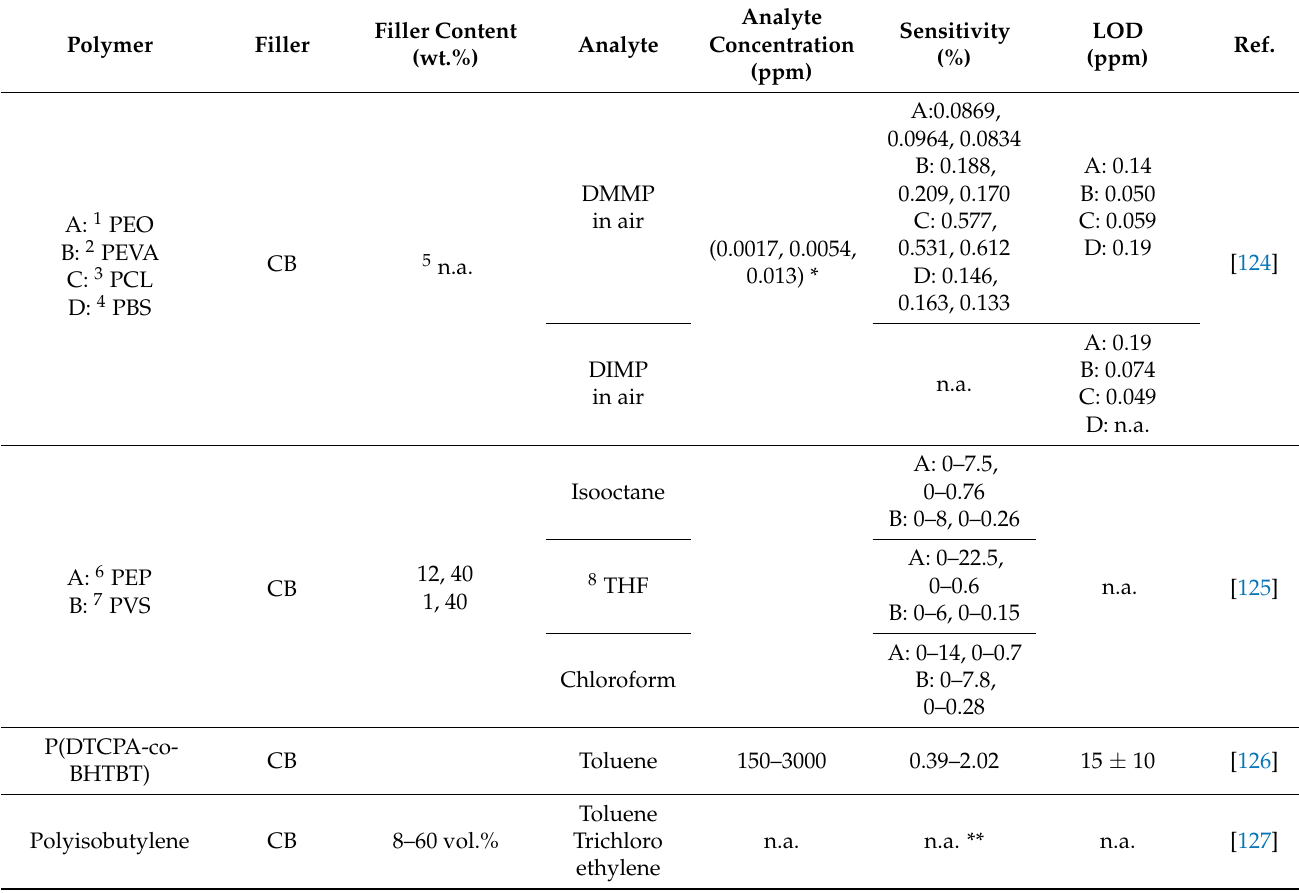
Table 8. CB/polymer nanocomposite films as chemiresistive